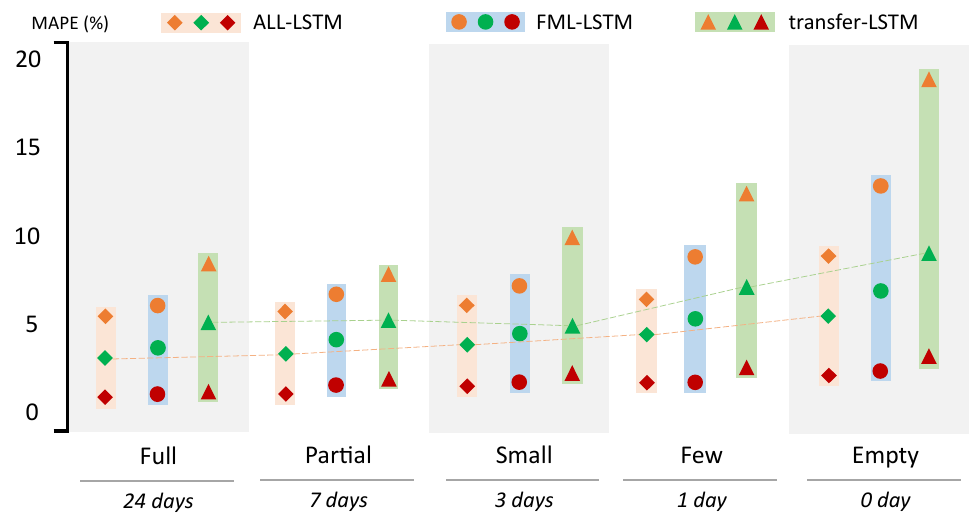
Figure 7. Result variance comparison among ALL-LSTM, FML-LSTM, Transfer-LSTM per data